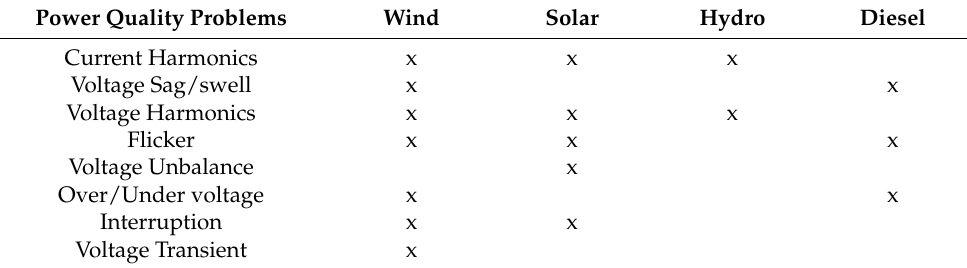
Table 1. Power quality problems related to DG